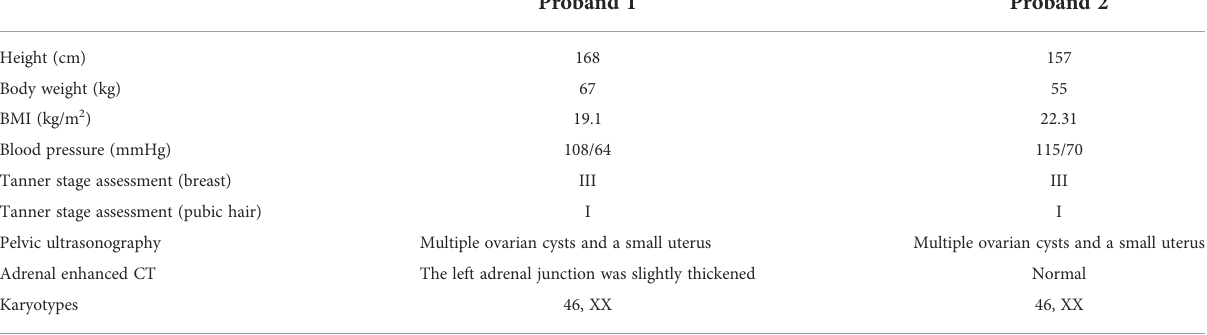
TABLE 1 Physical examination and auxiliary examinations of the patients.